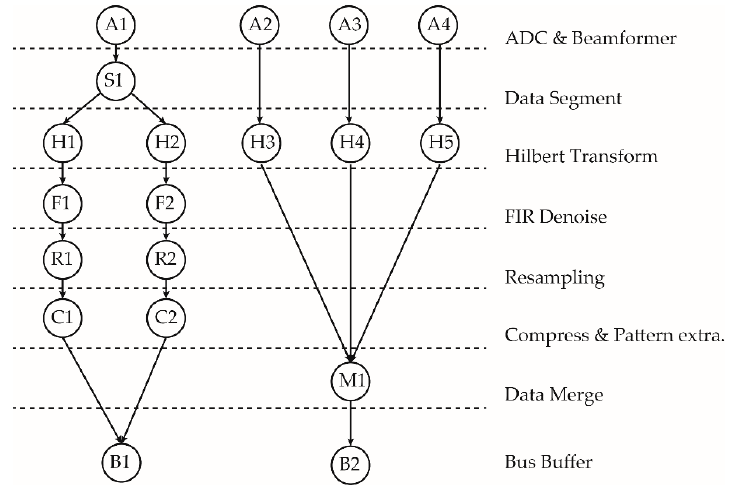
Figure 13. An example of two DAG scans.